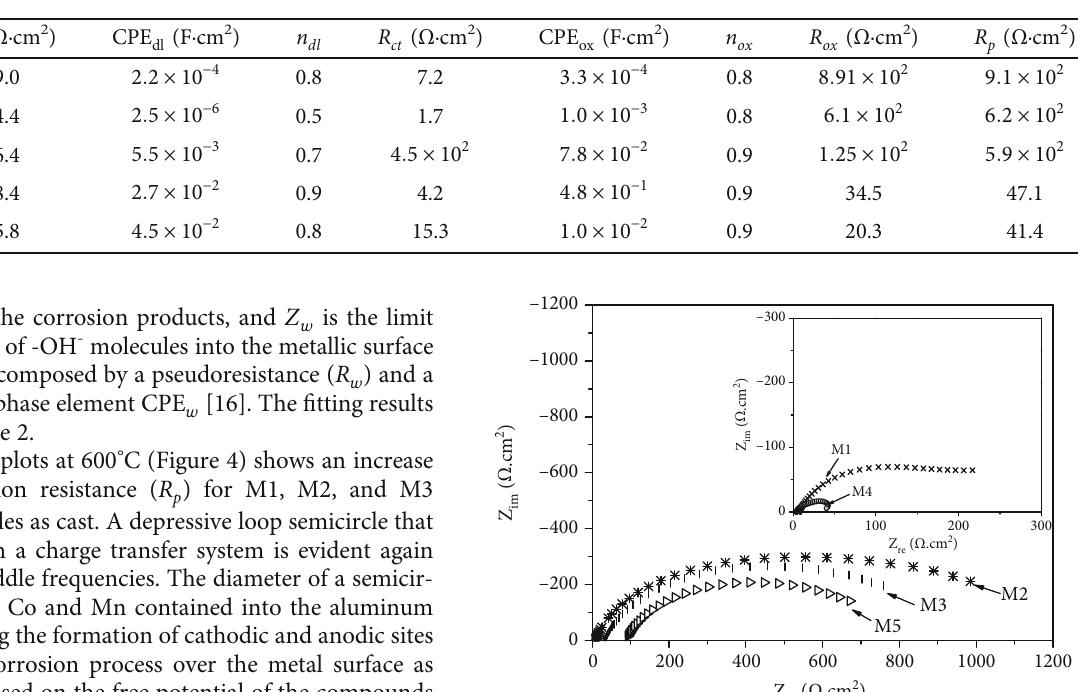
Table 3: Impedance parameters obtained through the equivalent circuit for aluminum-based alloy doped with Mn and Co after heat treatment at 600 ° C immersed in 3M KOH.